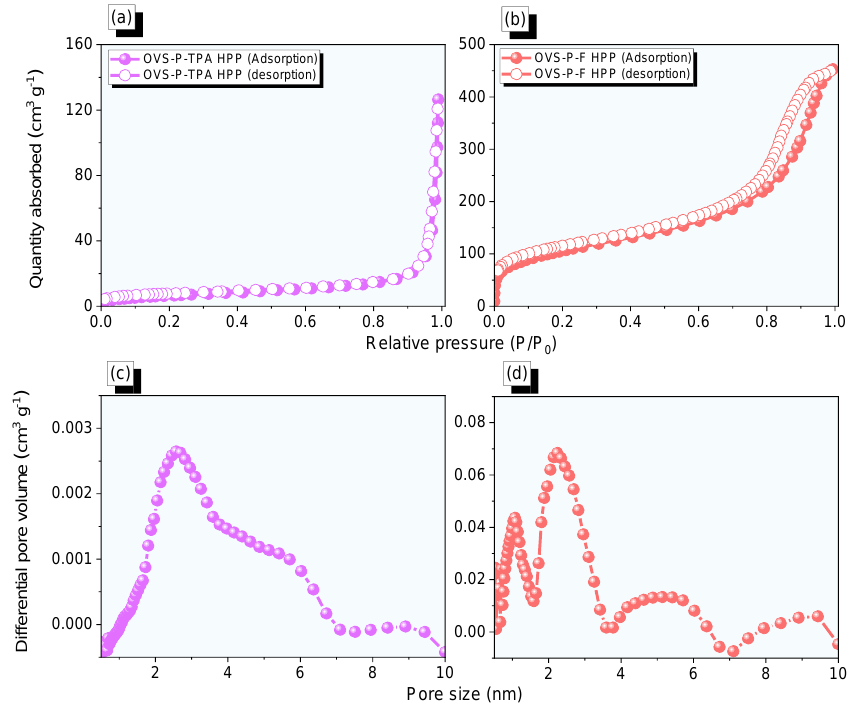
Figure 4. BET and pore size profiles of ( a , c ) OVS-P-TPA HPP and ( b , d ) OVS-P-F HPP. The shape and porosity parameters of the OVS-HPPs were evaluated using SEM and TEM measurements (Figure 5). The OVS-P-TPA and OVS-P-F HPPs featured irregular aggregated sphere structures and aggregated irregular cloud-like structures, respectively, according to the SEM images (Figure 5a,b). Moreover, the TEM images of the OVS-HPP materials are shown in Figure 5c,d; the images revealed the presence of pinholes and the presence of dark and bright regions in their structures.